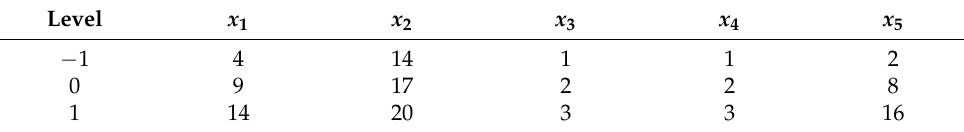
Table 1. Factor Level of Assembly Resources.